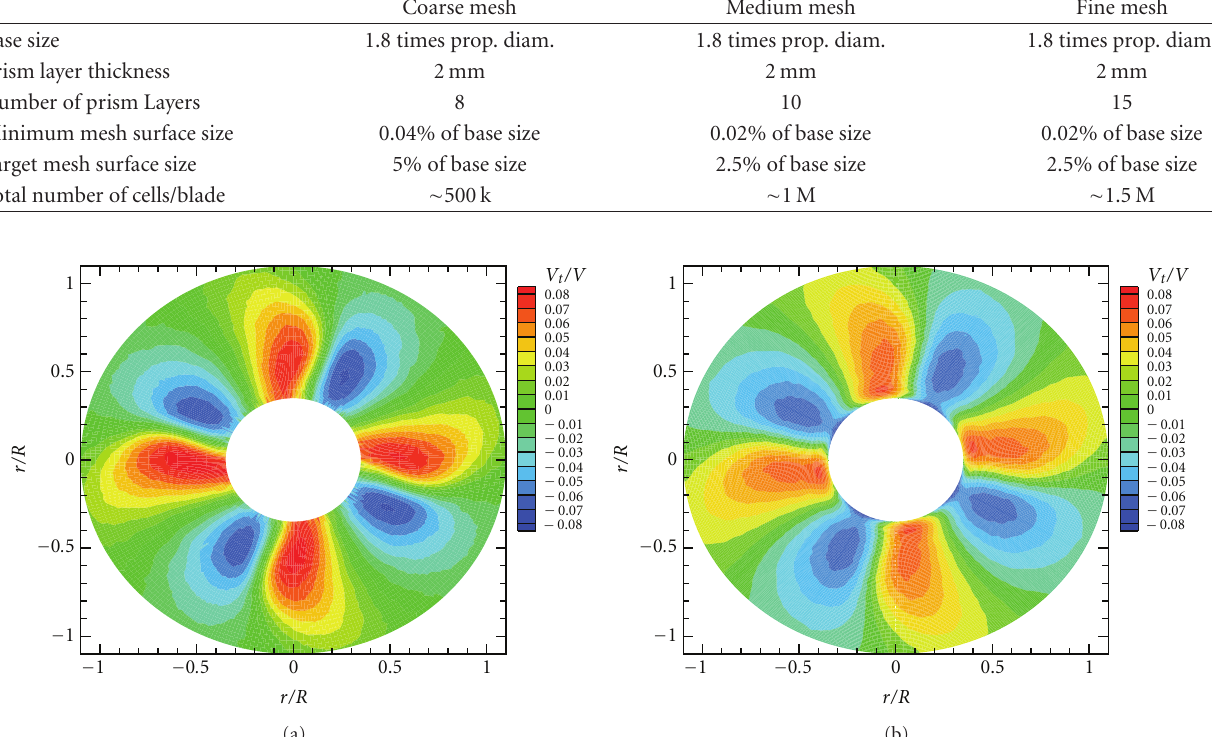
Figure 13: Tangential nondimensional velocity distribution at x/R = 0.2500 fore the propeller plane. (a) Experimental LDV measurements. (b) RANSE computations on the finer